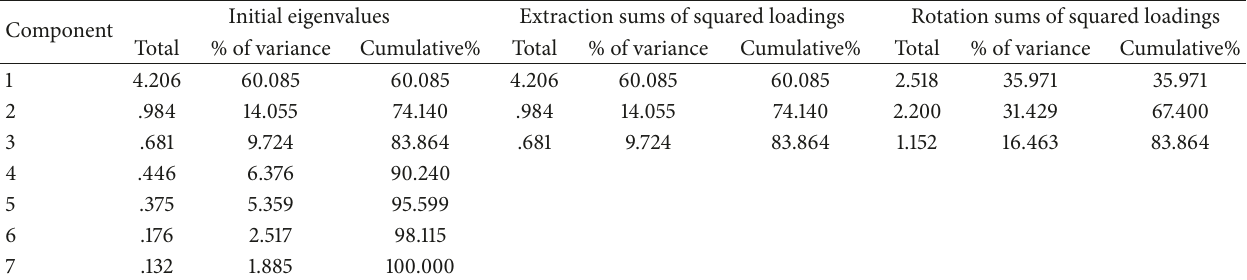
Table 3: Total variance explained.